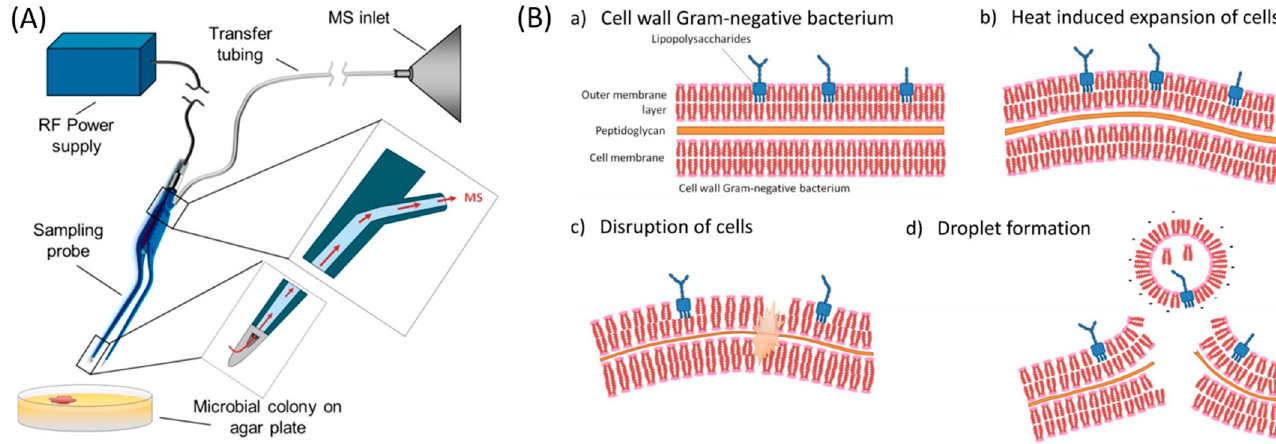
Figure 2. ( A ) Experimental setup for bacterial analysis using bipolar forceps with REIMS (reproduced from [12] ), and ( B ) droplet formation in REIMS (reproduced from [102] ).